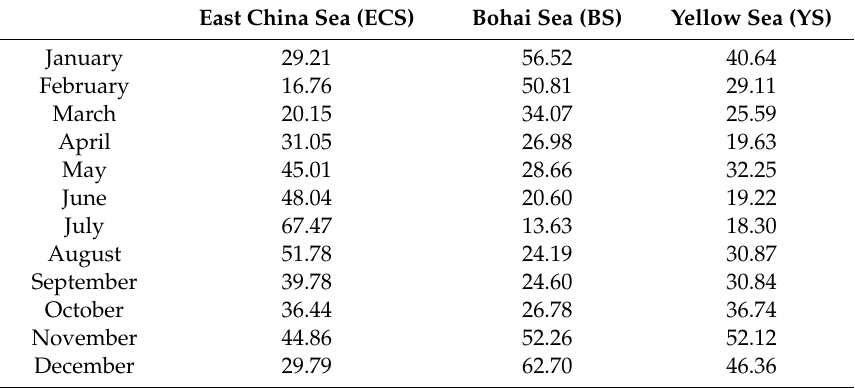
Table 1. Monthly averaged valid observations (%) of GOCI data from 2013 to